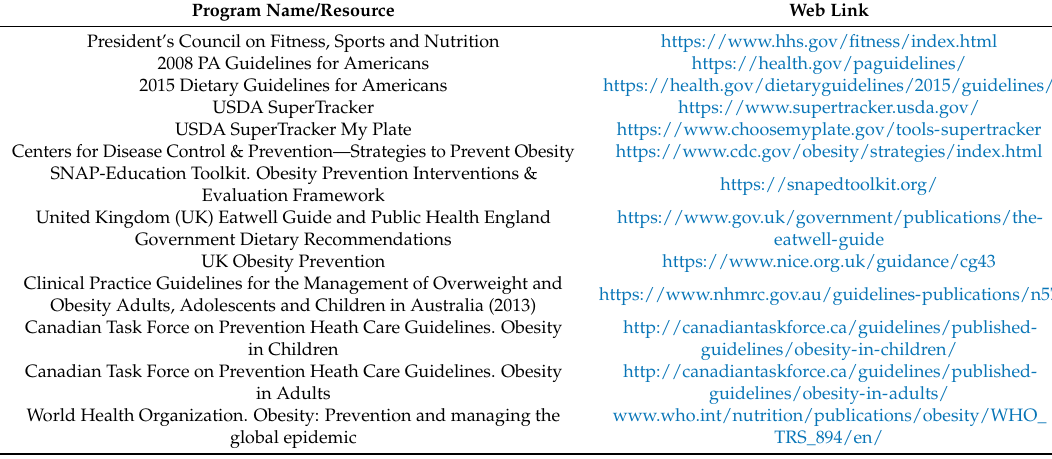
Table 2. Diet and physical activity (PA) resources designed for nutrition educators to use in their obesity prevention programs or to recommend to consumers to improve diet and